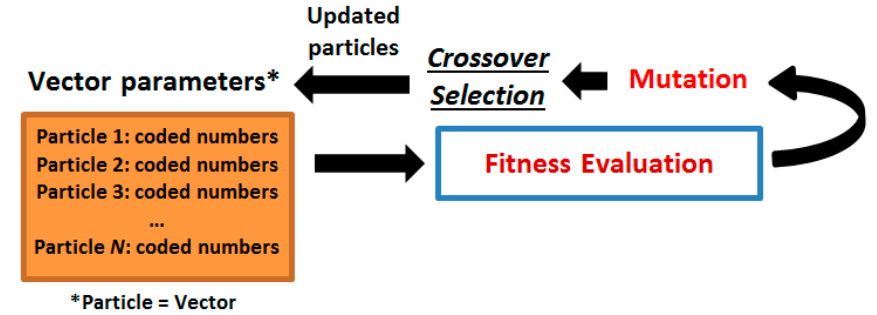
Figure 5. Algorithmic flow of the differential evolution algorithm.